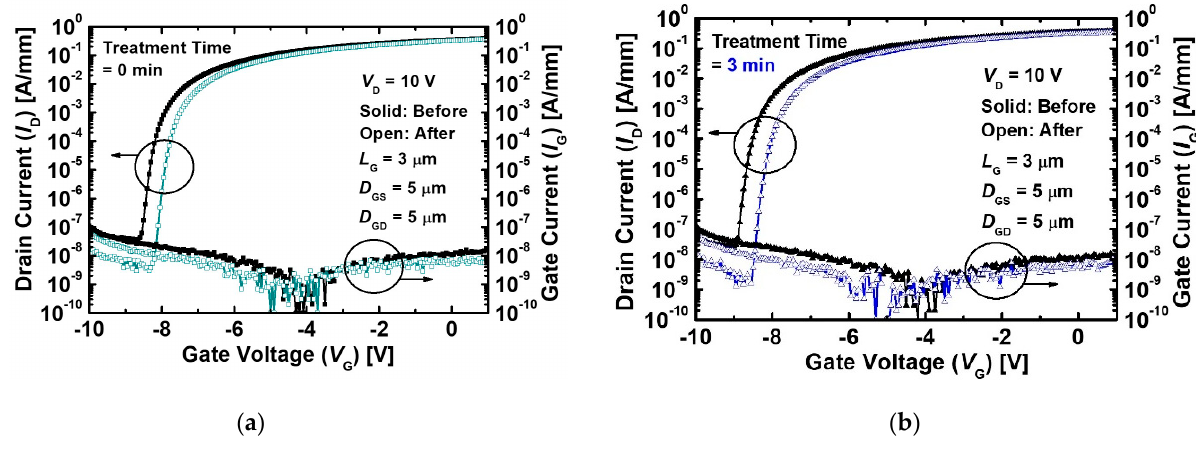
Figure 4. I D and I G characteristics as a function of V G before and after the proton irradiation of the MIS ‐ HEMTs ( a ) without the treatment and ( b ) with treatment for 3 min at a V D of 10 V.